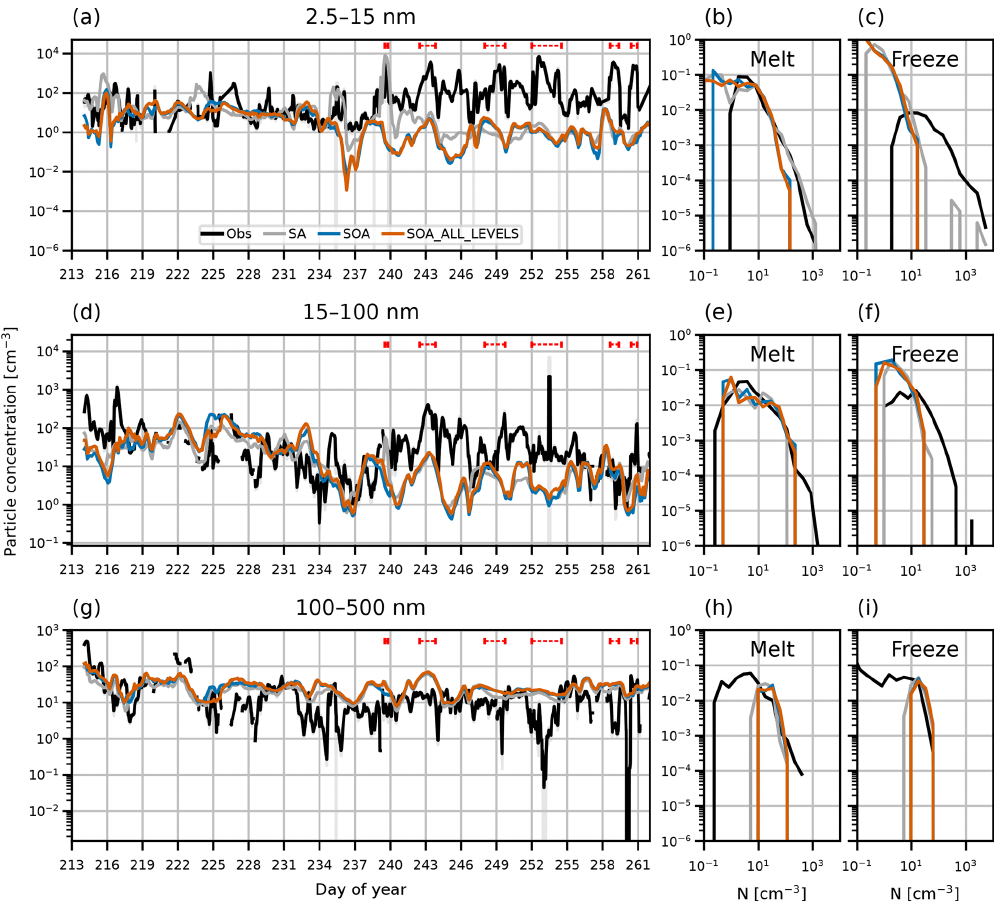
Figure B1. Time series and PDFs of surface aerosol concentration during AO2018 from observations and model output. Model output is from simulations SA (grey lines), SOA (blue lines) and SOA_ALL_LEVELS (orange lines). Observations are shown as 3-hourly mean (black lines) and standard deviation (grey shading). Aerosol concentrations are shown for particles with diameter (a–c) 2.5–15nm, (d–f) 15–100nm, and (g–i) 100–500nm. Dashed red lines in (a) , (d) , and (g) show observed NPF events. PDFs are separated by the observed sea ice